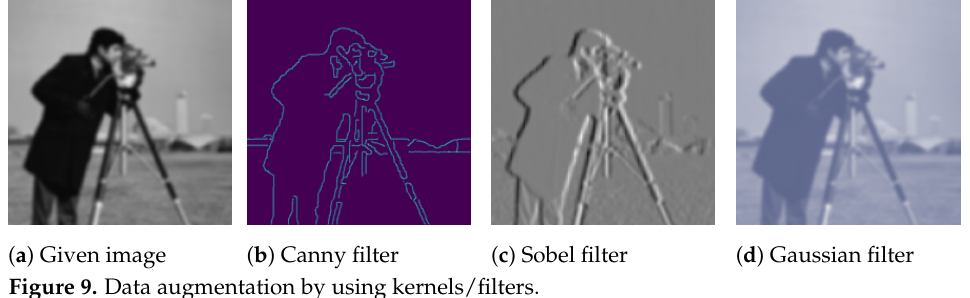
Figure 9. Data augmentation by using